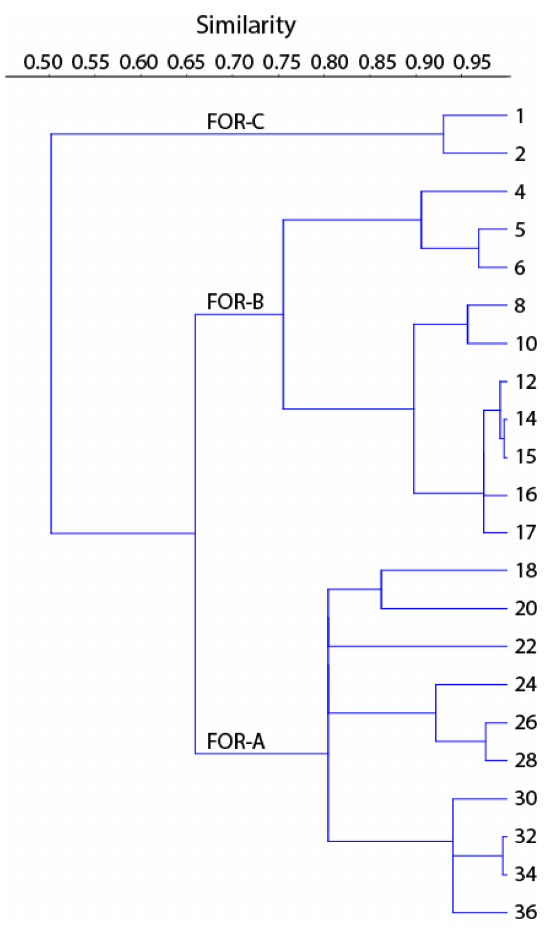
Figure 6. Dendrogram produced by the cluster analysis based on the Morisita index and the UPGMA clustering method.